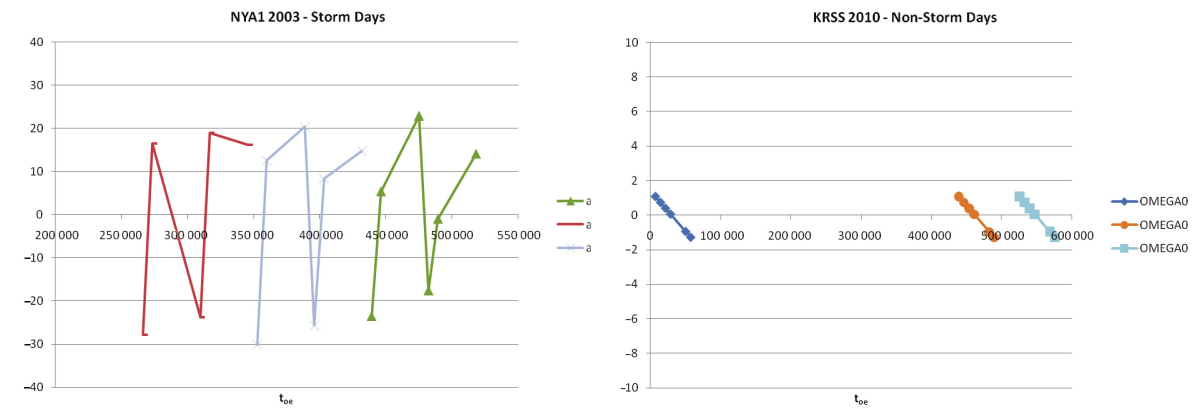
Fig. 8. a semi-major axis of three stormy days in 2003 using cPOS stations (NYa1)